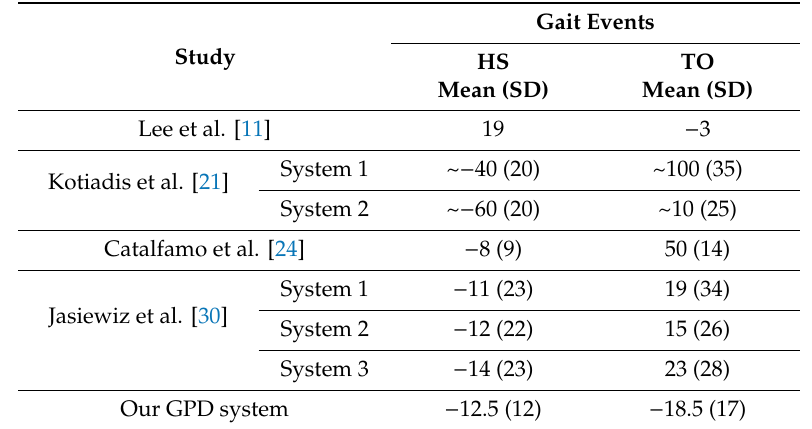
Table 6. Mean and one standard deviation (SD) of calculated delays in studies that evaluated their